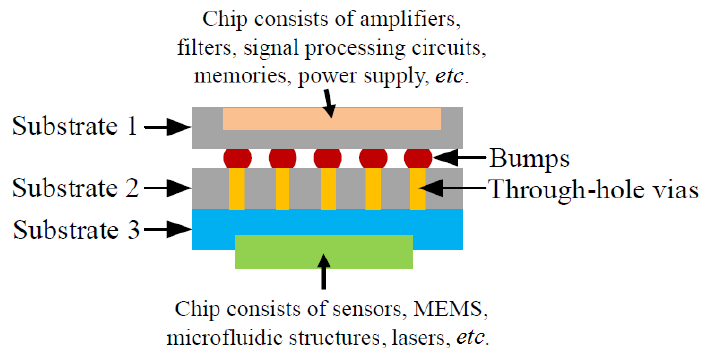
Figure 2. Schematic of vertical interconnections between bumps and through-hole vias for the components shown in Figure